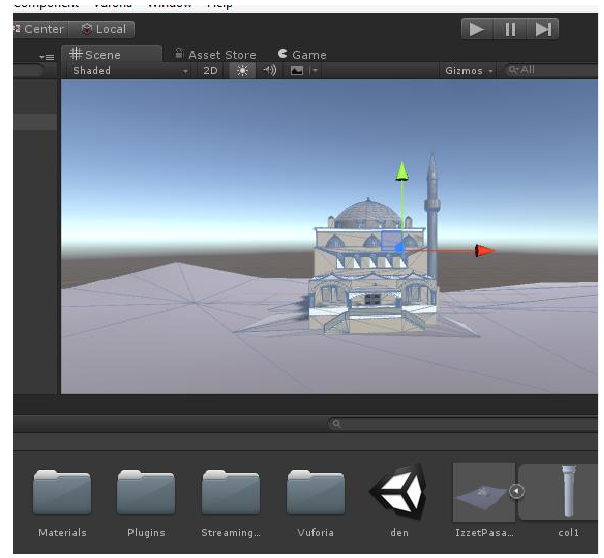
Figure 4. Importing 3D Models into the Unity Environment